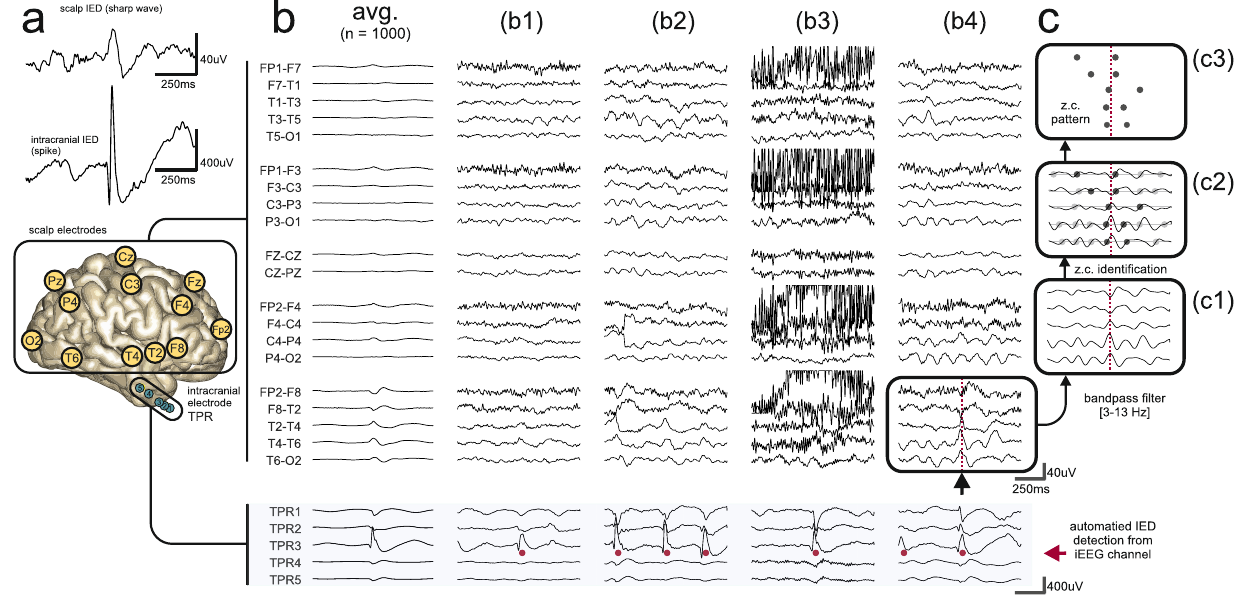
Figure 1. Examples of scalp EEG waveforms associated with intracranial IEDs. ( a ) Scalp IEDs are less clear than their intracranial counterparts which results in inferior SNR. ( b ) Representative examples of incomplete discharge propagation (FCD + HS subject) in simultaneous scalp EEG and iEEG recordings. For clarity, only the right lateral temporal chain of scalp electrodes is illustrated. Automatically detected intracranial IEDs are marked by red dots under the intracranial portion of the signals (light blue background). Associated scalp waveforms are below ( b1 , b3 ) or near the limit of visual identifiability ( b2 , b4 ) but all were robustly detectable as a scalp zero-crossing pattern. ( b2 ) shows trial-to-trial variability. ( b3 , b4 ) show how scalp EEG artifact or background rhythms interfere with visual detection. The first column (avg.) shows a small waveform resulting from signal averaging (c.f. Fig. 3a of Koessler et al. 18 ). ( c ) Transformation of a multi-channel scalp EEG signal